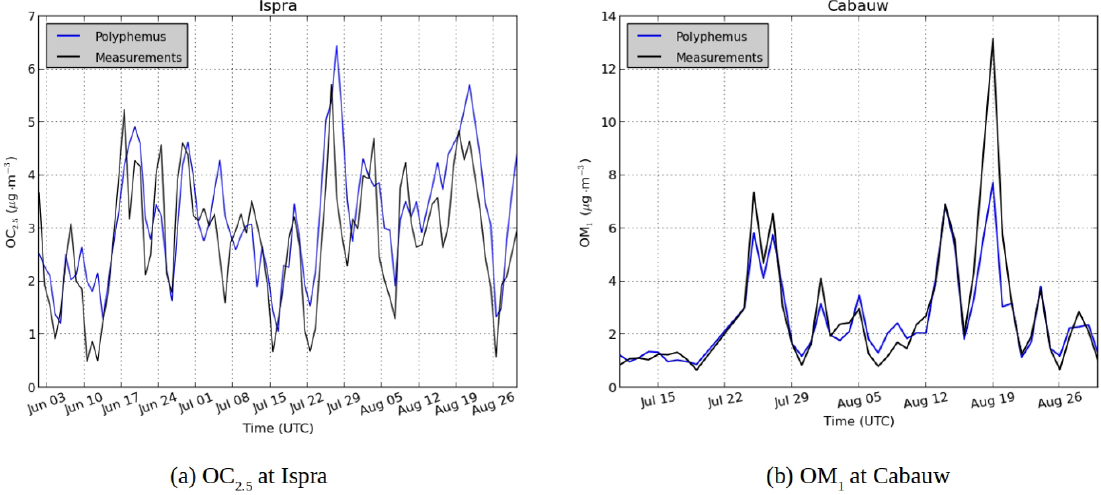
Figure 6. Comparison of modeled SOA concentrations (blue) with observations (black) for (a) OC 2 . 5 concentrations at Ispra and (b) OM 1 concentrations at